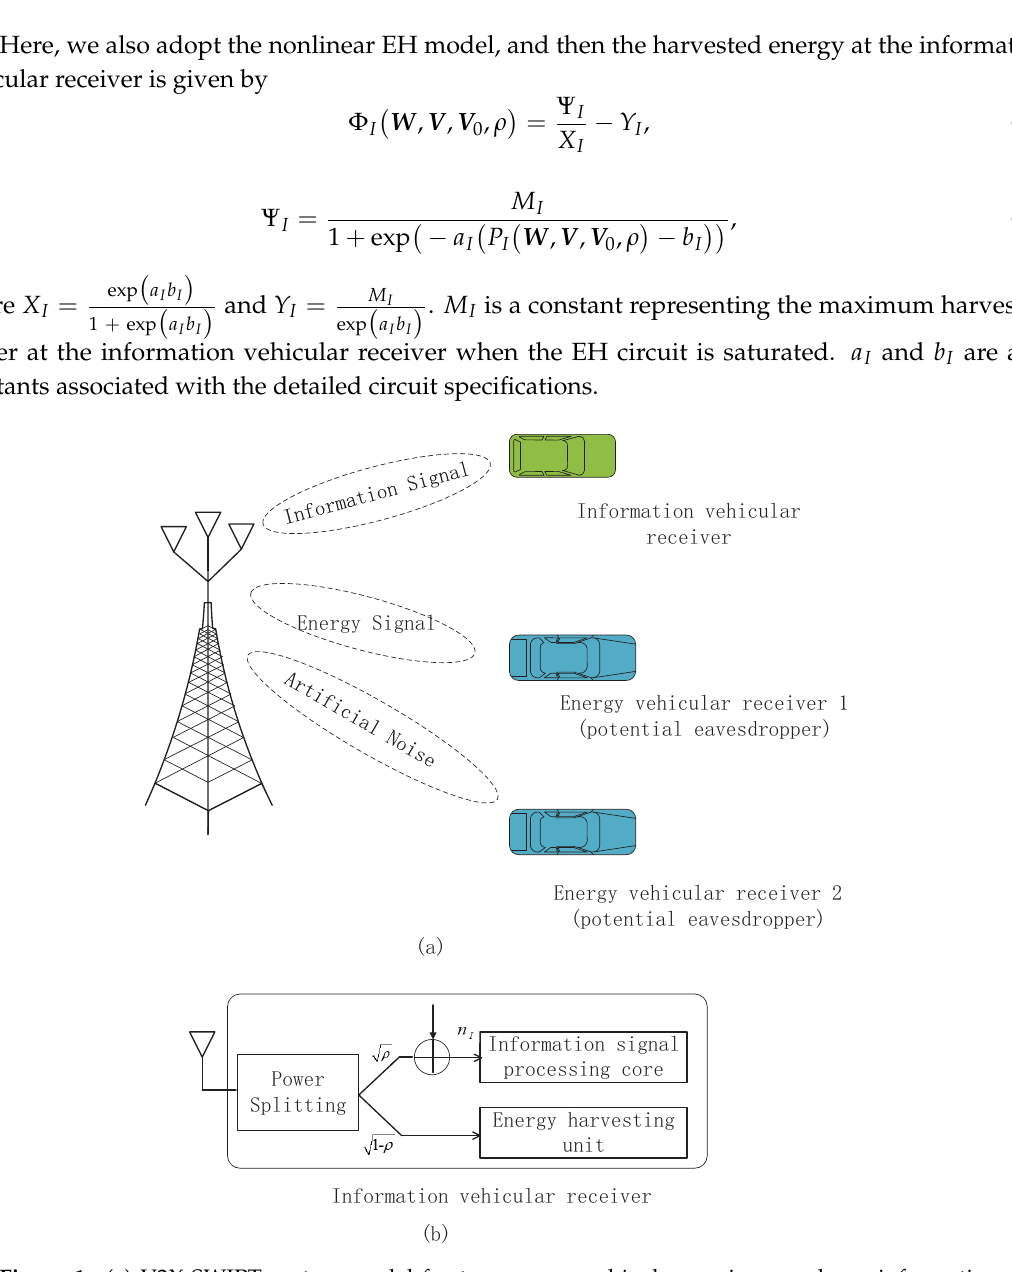
Figure 1. ( a ) V2X-SWIPT system model for two energy vehicular receivers and one information vehicular receiver; ( b ) the block diagram of the information vehicular receiver model for wireless information and power